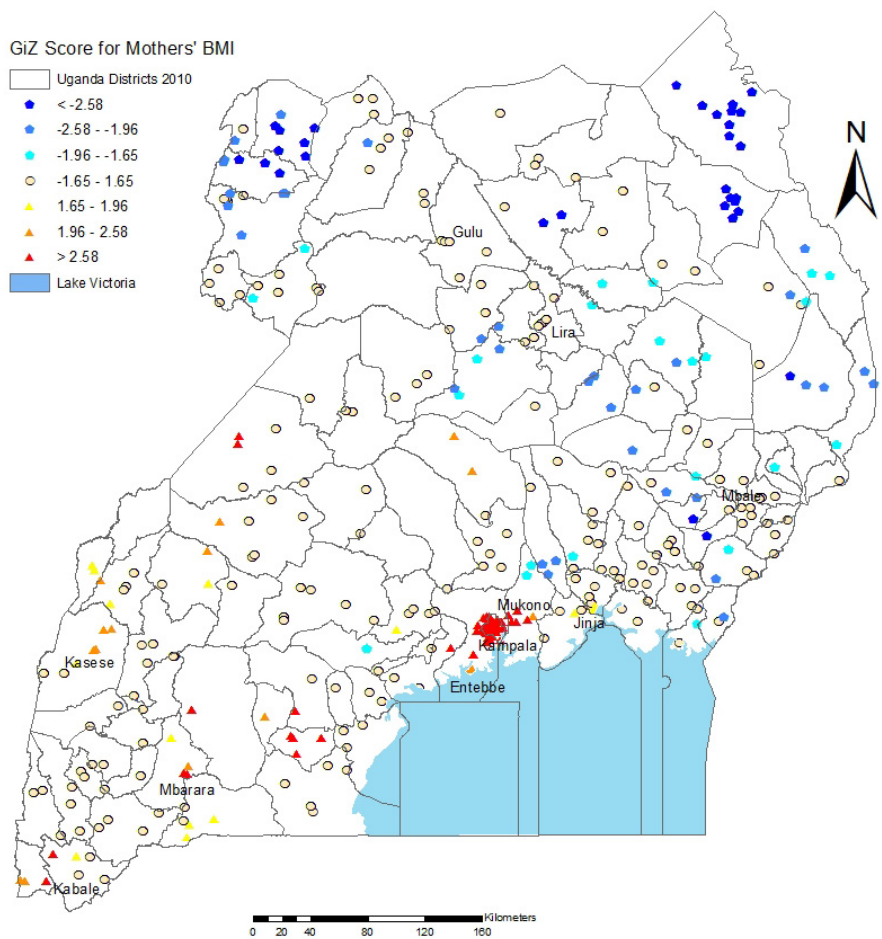
Figure 3. Hot and cold spots of maternal BMI. Dark red dots represent hot spots of high maternal BMI, and dark blue dots represent cold spots of low maternal BMI at the 95% statistical significance level. Each dot represents a cluster of DHS sample households, while the boundaries shown are districts. Dots inside Lake Victoria are located on